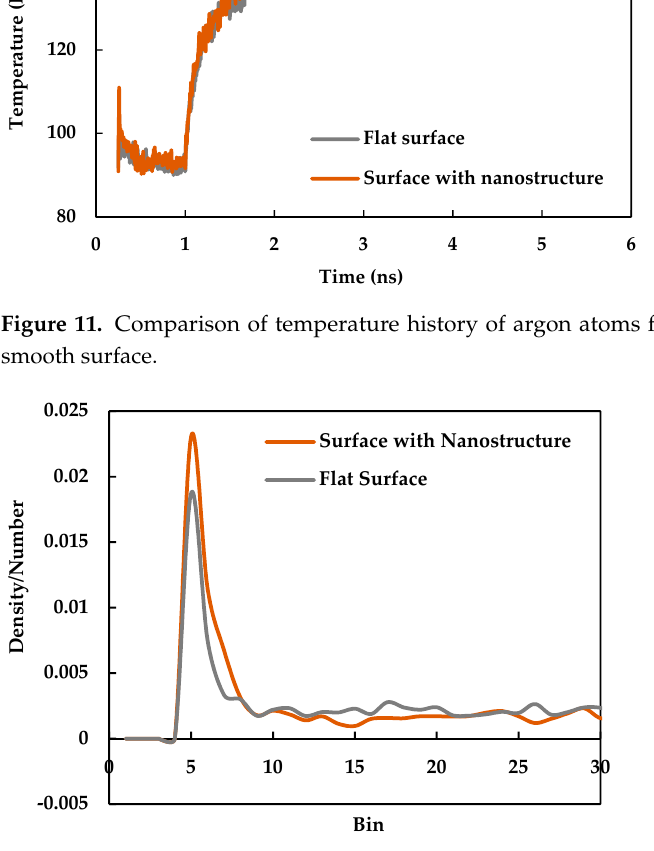
Figure 12. Comparison of density profile of argon at 4 ns for nano-structured surface with smooth surface.